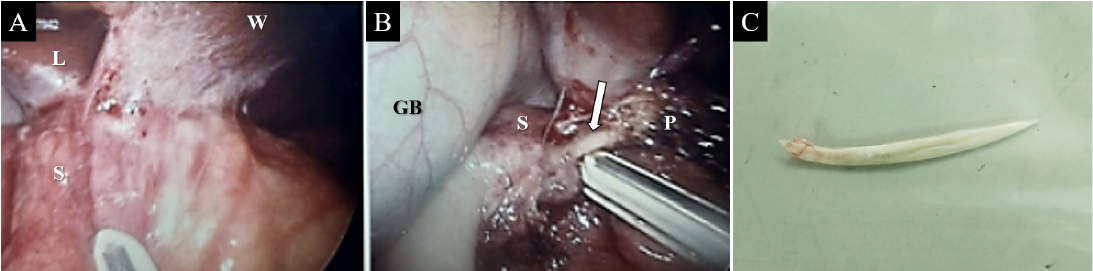
Figure 2. Laparoscopic view displaying severe adhesion between the distal stomach and liver ( A ). A linear and hard foreign body (arrow) was observed between the gastric antrum and the pancreatic head ( B ). The removed foreign body measured 4 cm in length and resembled a fish bone ( C ). Note— L = liver; S = stomach; W = abdominal wall; GB = gallbladder; P = pancreas.